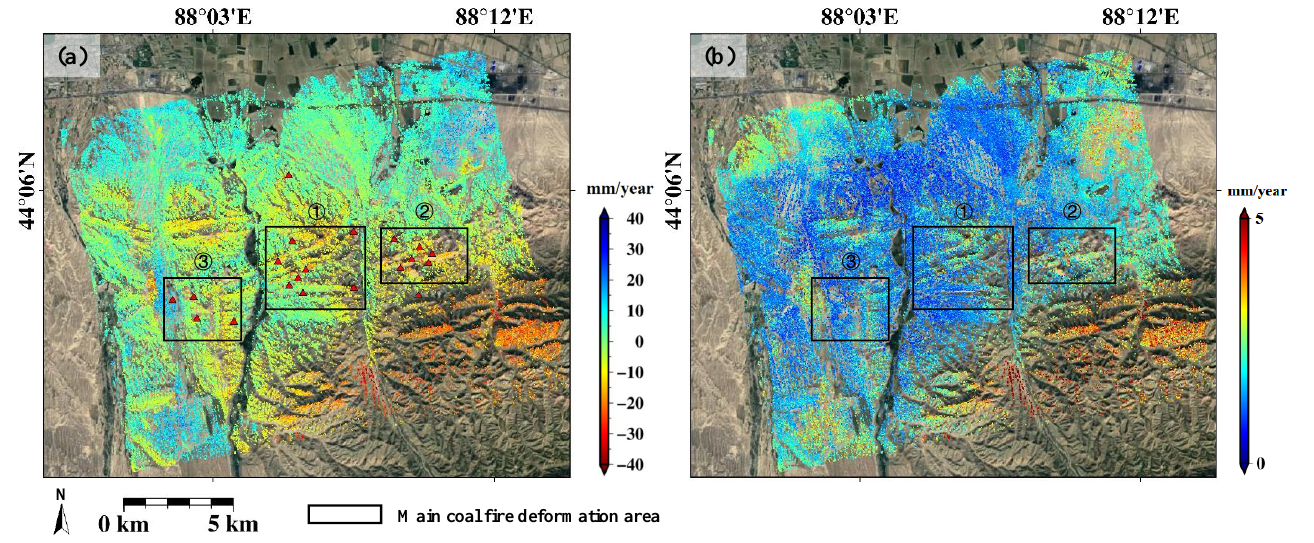
Figure 11. The results of GACOS-Corrected Stacking-InSAR. ( a ) is deformation monitoring result and ( b ) is standard deviation of the LOS velocity. The black boxes in ( a ) indicate the three main coal fire deformation areas over the study area.